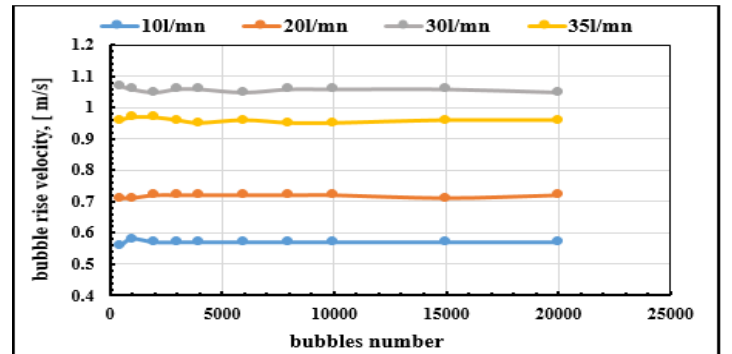
Figure 3. Convergence of bubble size.